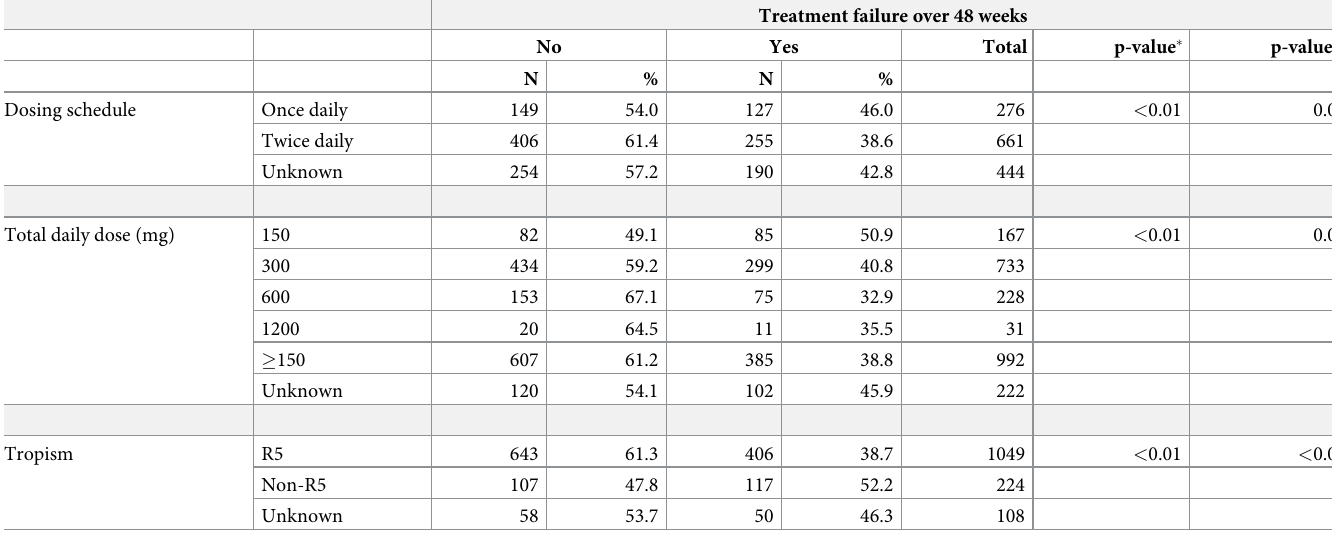
Table 6. Univariate logistic regression analysis of the association between non-standard maraviroc uses and treatment